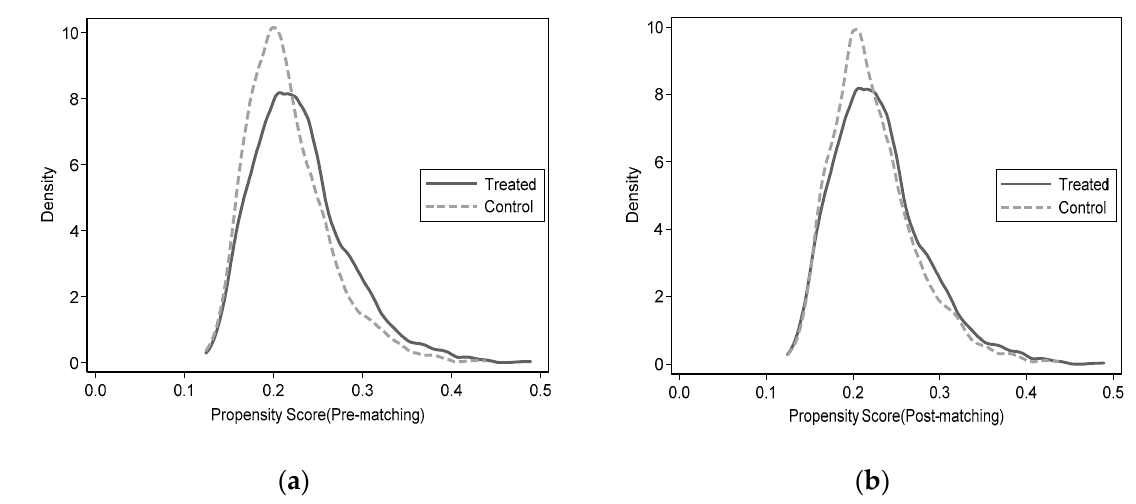
Figure 2. Kernel probability distribution before and after matching.